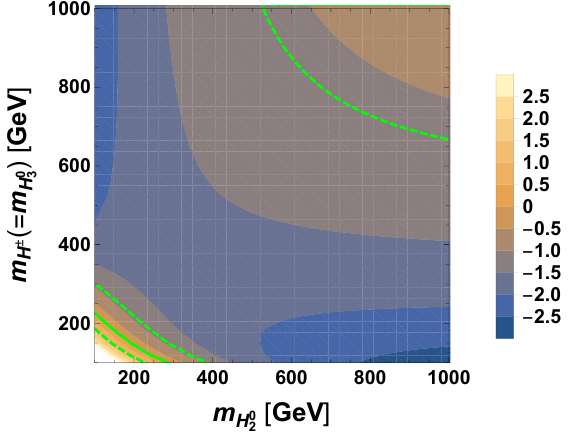
Figure 2 . Contour plot for the electron EDM d e in the unit of 10 (cid:0) 29 e cm as a function of m m (= m ) with ( (cid:18) u ; (cid:18) d ; (cid:18) e ; (cid:18) 7 ) = (2 ; 0 ; (cid:25)= 2 ; 1), j (cid:21) 7 j = 0 : 3, j (cid:16) u j = 0 : 01, j (cid:16) d j = 0 : 1 and j (cid:16) e j = 0 : 5 H (cid:6) H 0 3 at the scale m Z in the panel. The green solid line denotes d e = 0 and the area between the green dashed lines is the allowed region against the constraint from the electron EDM.